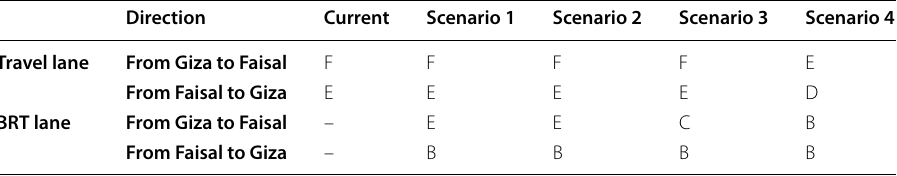
Table 3 LOS evaluation of travel/BRT lanes for each scenario Direction Current Scenario 1 Scenario 2 Scenario 3